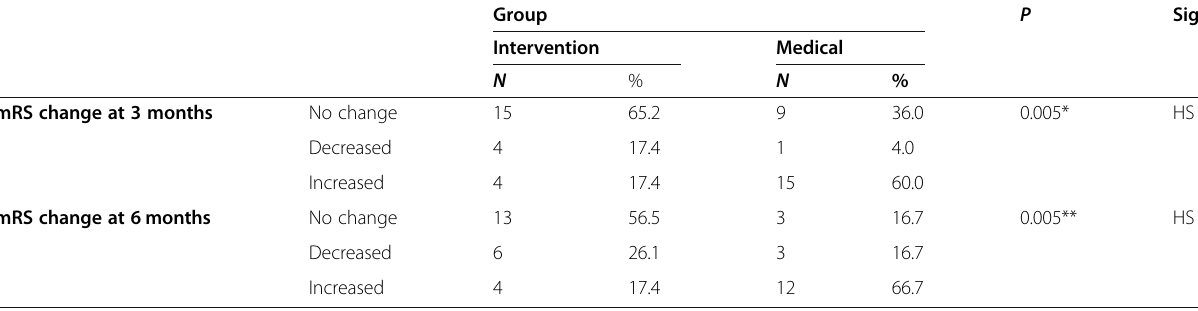
Table 6 Change of mRS at 3 and 6 months of both groups